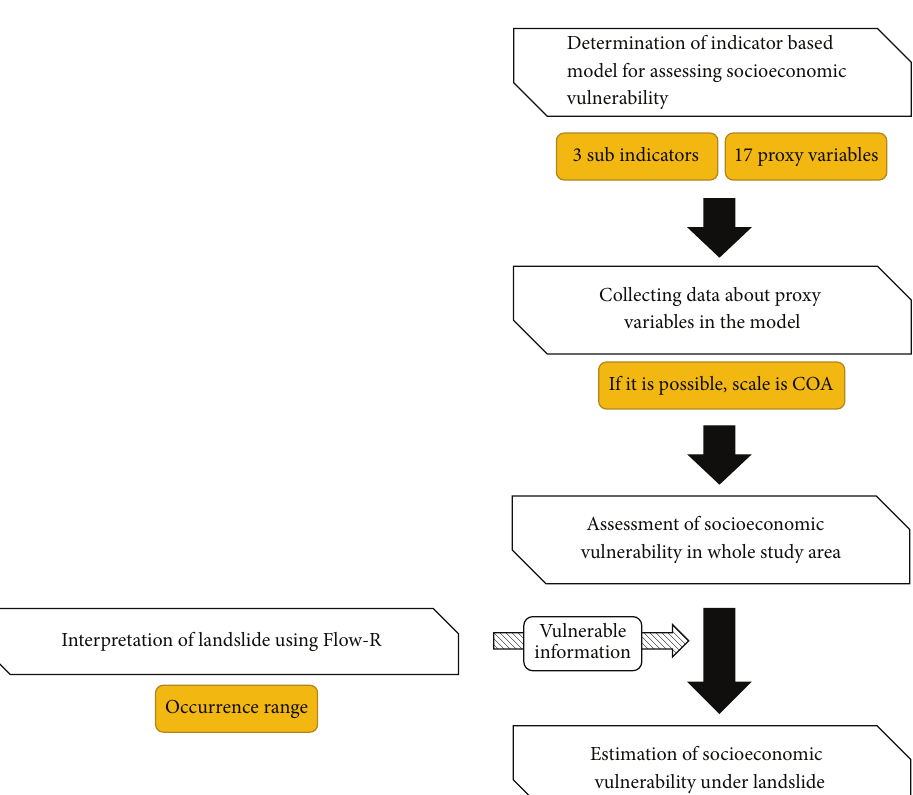
Figure 5: Procedure of socioeconomic vulnerability